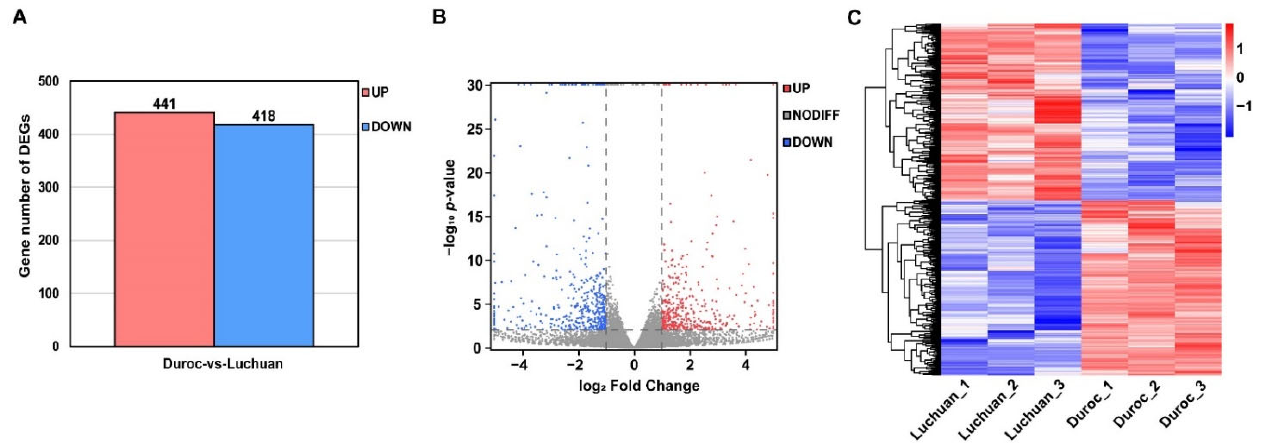
Figure 2. Identification of DEGs. ( A ) The statistical analysis of DEGs between Duroc and Luchuan adipose. ( B ) The volcano map of DEGs. The gene with p ‐ value < 0.01 and log 2 Fold Change > 1 is marked in red; the gene with p ‐ value < 0.01 and log 2 Fold Change < − 1 is marked in blue. ( C ) Duroc and Luchuan adipose tissue can be clearly distinguished based on their transcriptome characteristics. The color key (from blue to red) of abundance value indicated low to high expression levels.